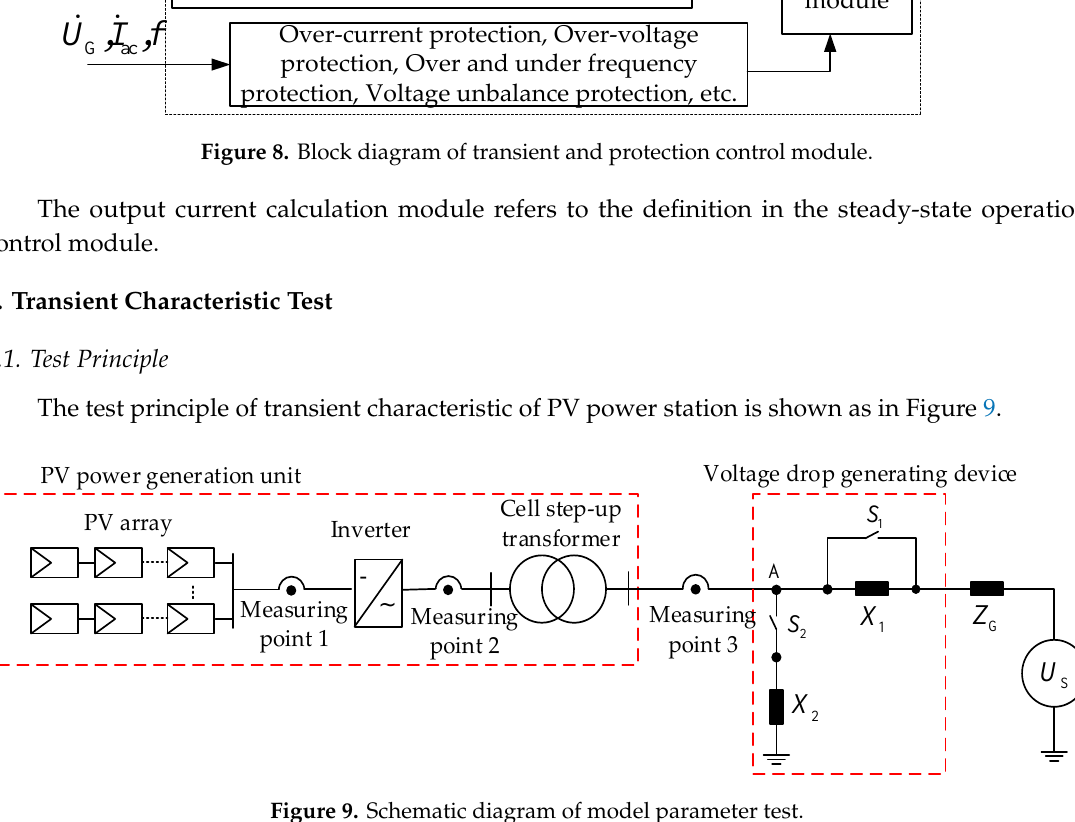
Figure 9. Schematic diagram of model parameter test.